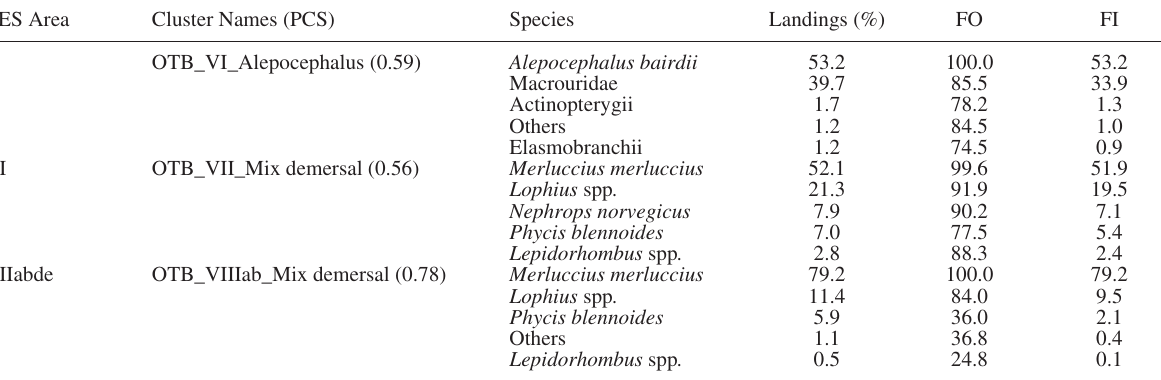
Table 2. – Catch profile (percentage in weight, frequency of occurrence and feeding index) by cluster and area for bottom otter trawl (OTB) (PCS: partial coefficient silhouette). ICES Area